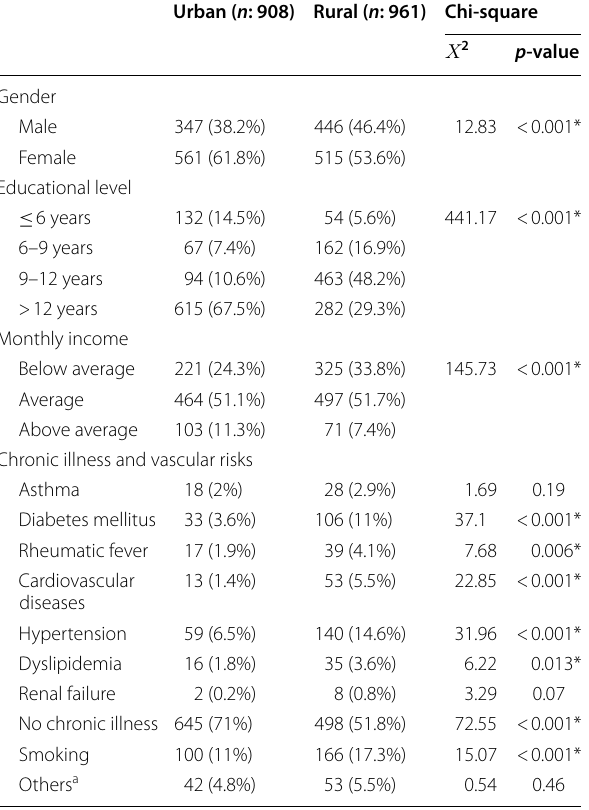
Table 1 Sociodemographic characteristics of participants